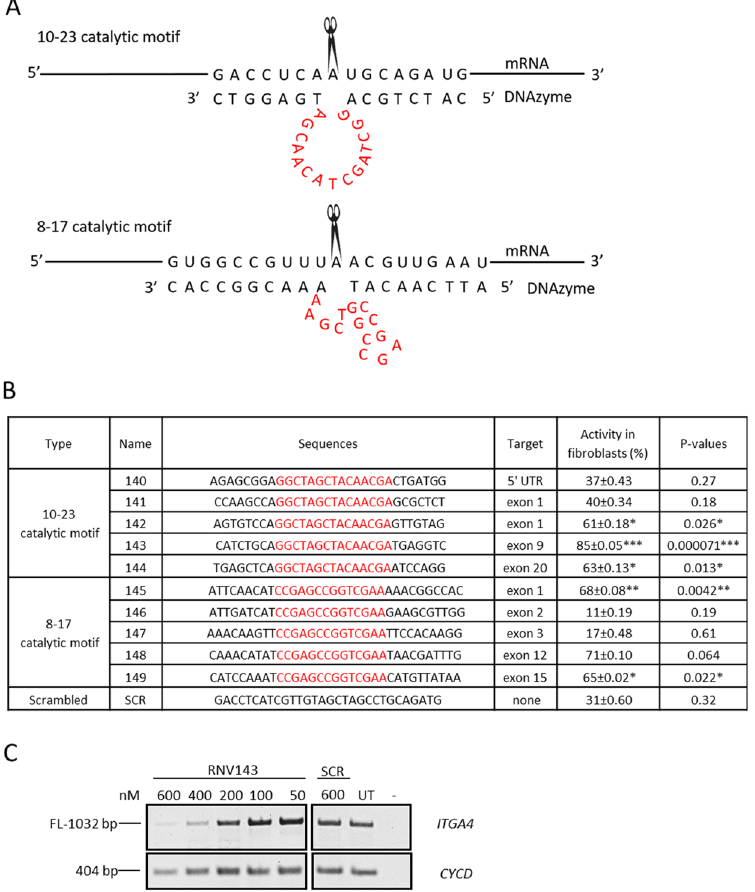
Figure 2. ( A ) Schematic illustration of the 10–23 and 8–17 catalytic motifs of DNAzymes. ( B ) Table for the activities of first-generation DNAzymes targeting ITGA4 mRNA that is directly correlated with the percentages of ITGA4 mRNA knockdown (See Materials and Methods for detailed procedures); The catalytic motifs are shown in red, the arm regions are in black, and the sequences are from 5 ′ → 3 ′ . p-values were calculated for the activity in fibroblasts which was normalised to the UT using student t-test and * Indicates p-value < 0.05, ** Indicates p-value < 0.005 and *** Indicates p-value < 0.0005. p-values have been rounded to 2 s.f. ( C ) Representative RT-PCR products of the ITGA4 and CycD transcripts from normal human primary fibroblasts after treatment with DNAzyme at different concentrations. The RT-PCR products after treatment with RNV143 are shown here. FL, full-length; UT, untreated; SCR, scrambled sequence; CYCD was used as a loading control. The gel images were cropped to highlight the ITGA4 specific products and the corresponding house-keeping gene control CYCD . The original images are shown in Figure S2 (Supplementary Information).